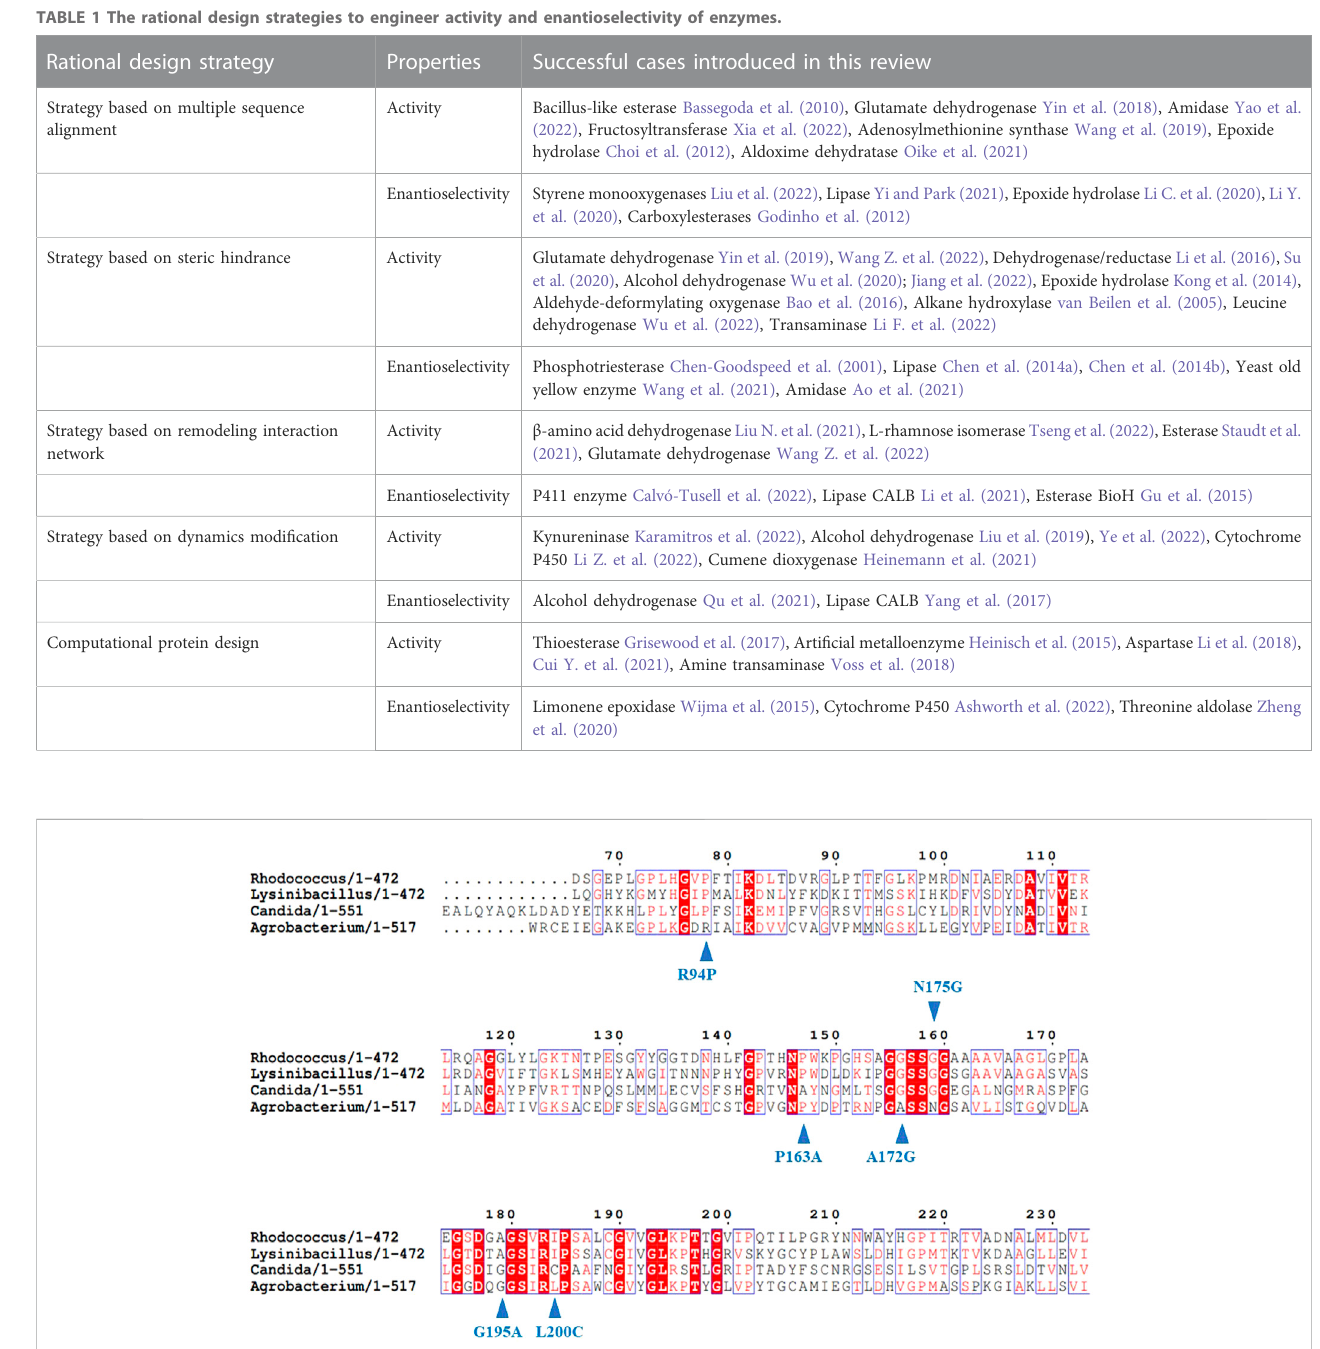
Frontiers in Bioengineering and